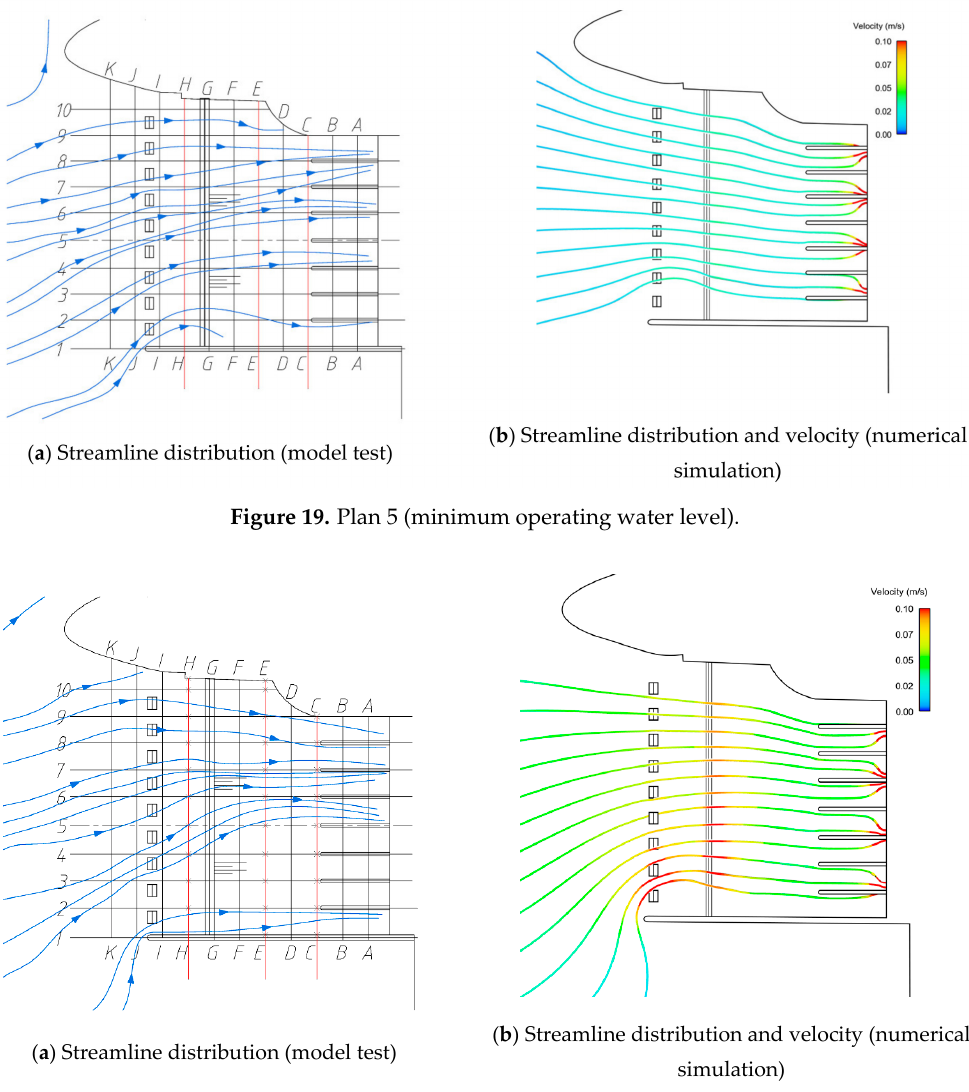
Figure 20. Plan 5 (design operating water level).